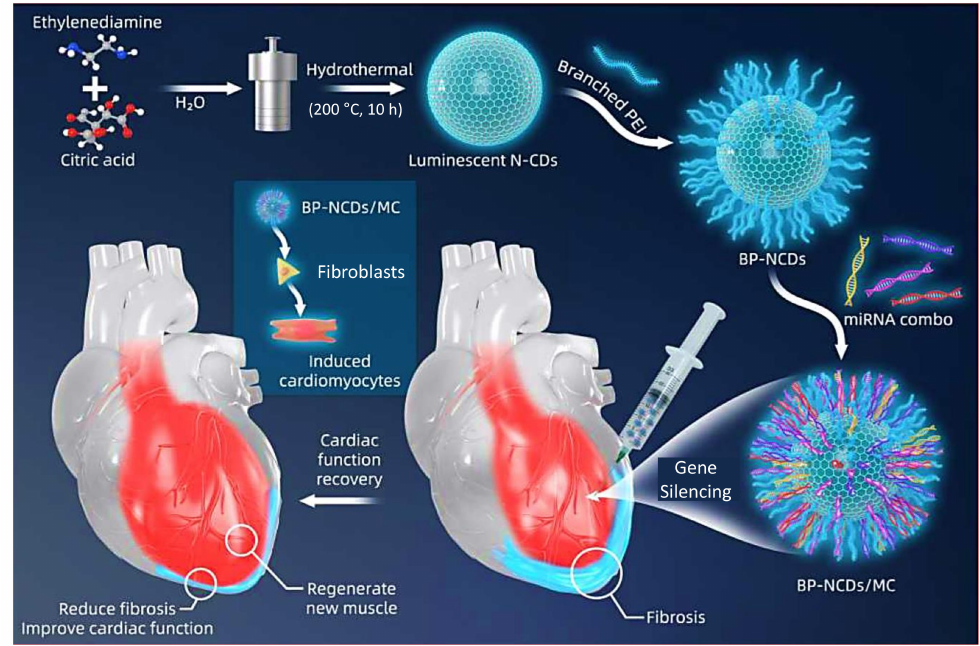
Figure 25. Synthesis of BP-NCDs and their application as a gene carrier for miRNA-combo delivery